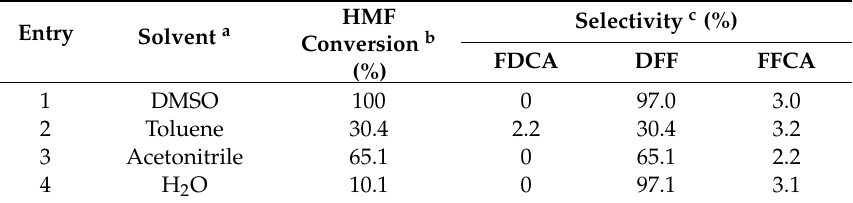
Table 1. E ff ects of solvents on the oxidation of HMF to